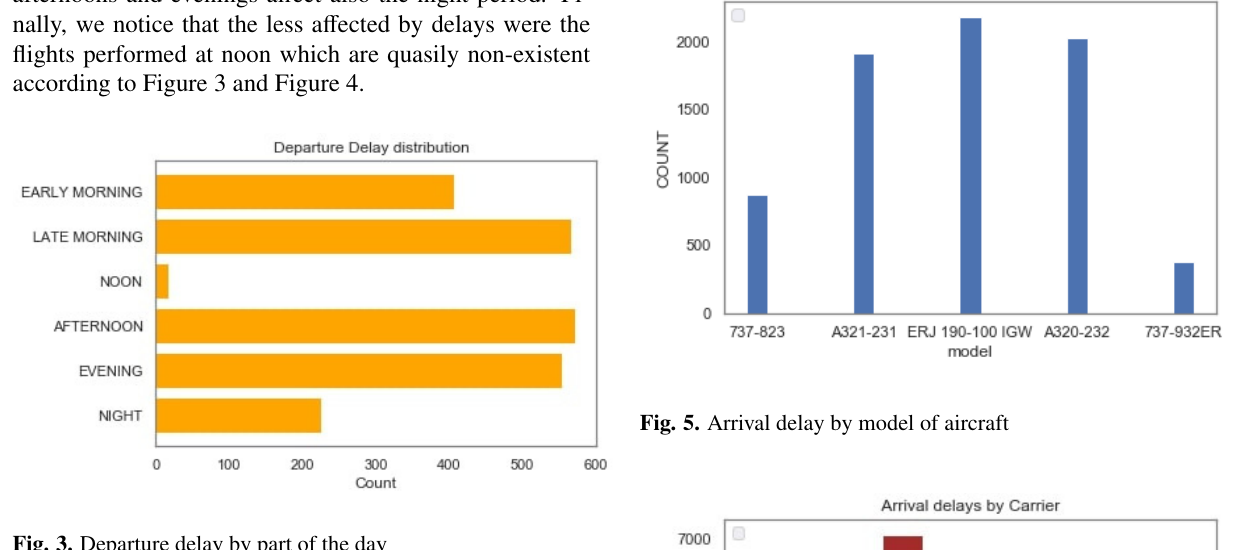
Fig. 3. Departure delay by part of the day